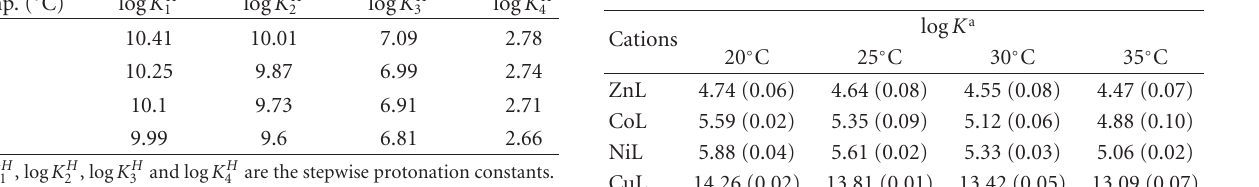
Table 2: Stepwise stability constants for the complexation of (BAPP) with 3d divalent metal ions in aqueous solution at 0.1 M NaNO 3 at di ff erent